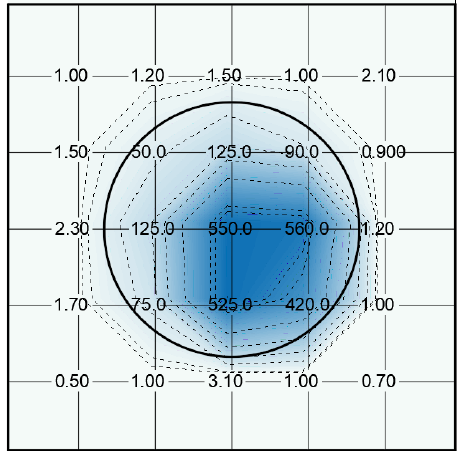
Figure 9. Example of spatial distribution of d 33 constant in a sample charged with an epoxy dielectric layer with an epoxy thickness of 400 µ m. The numbers indicate the value of the d 33 constant in the measurement points and the circle the position of the high-voltage